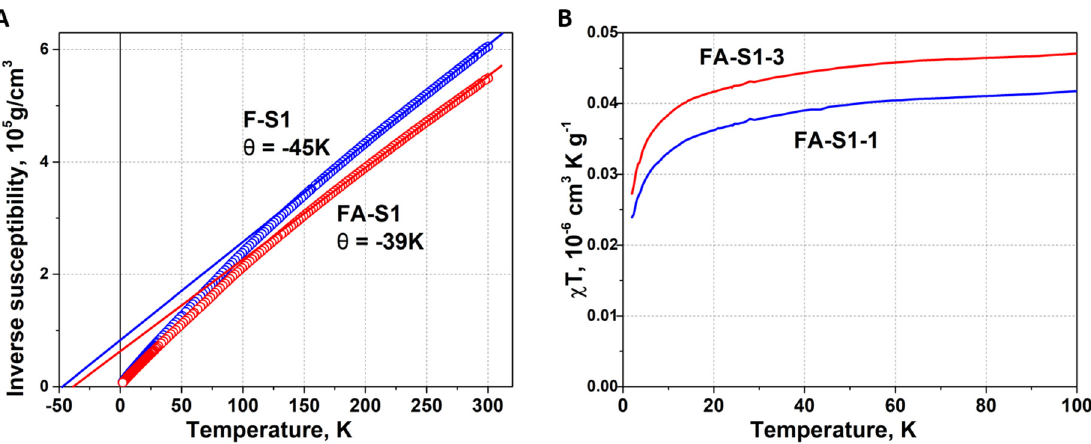
Figure 7. A:Temperature dependence of the inverse susceptibility for samples F-S1 and FA-S1. H = 1 kOe. Extrapolation was done from the high-temperature region (150-300 K). B: Temperature dependence of the value ( χ ·T) for samples F-S1 and FA-S1. H = 1 kOe.